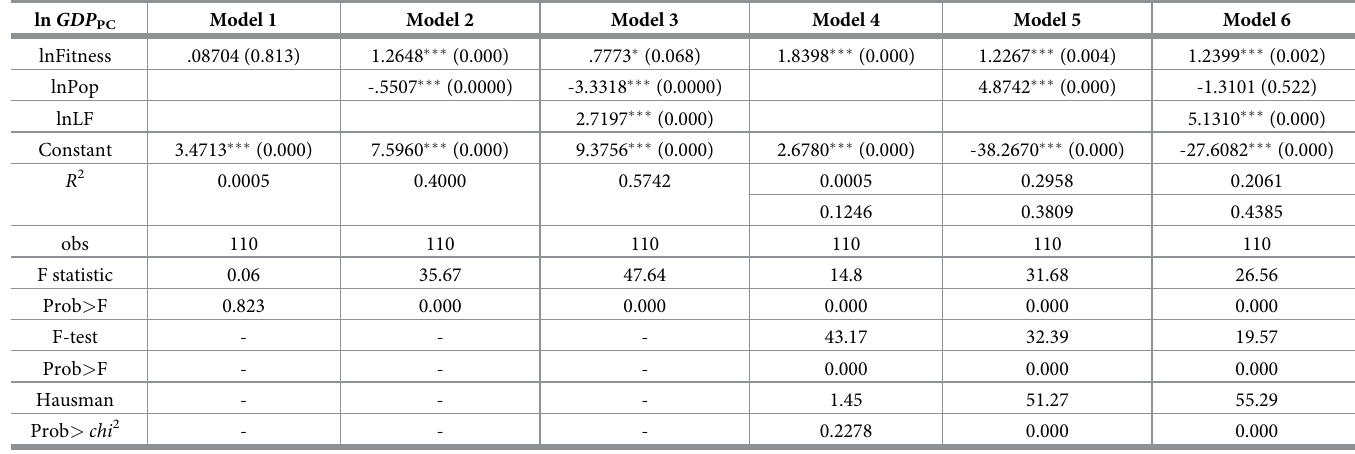
Table 2. Regression results of the mixed regression model and fixed effect model of economic fitness for GDP prediction after HMM noise reduction.